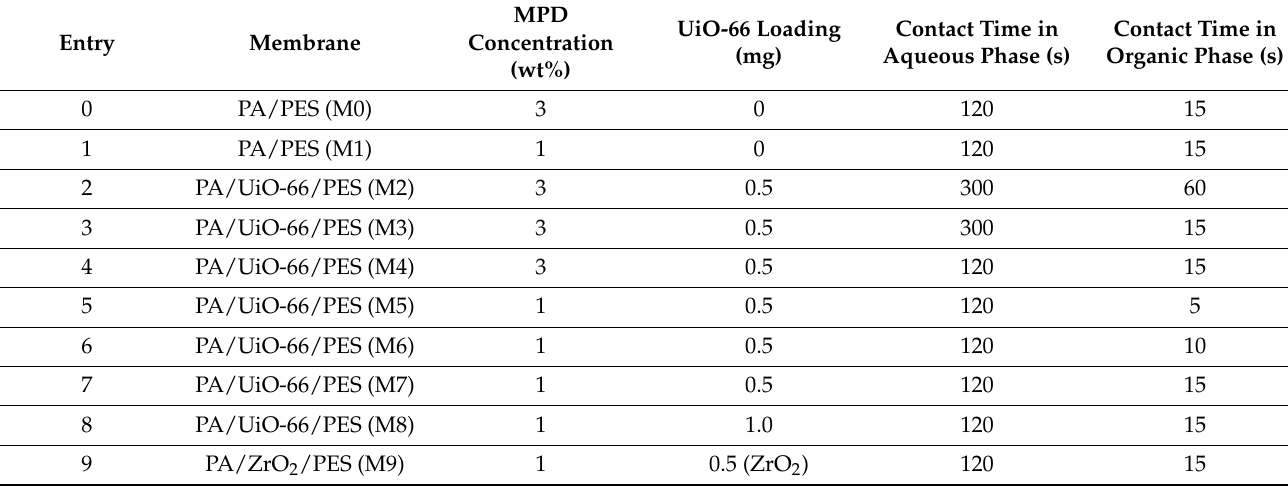
Table 2. Membranes being prepared in this